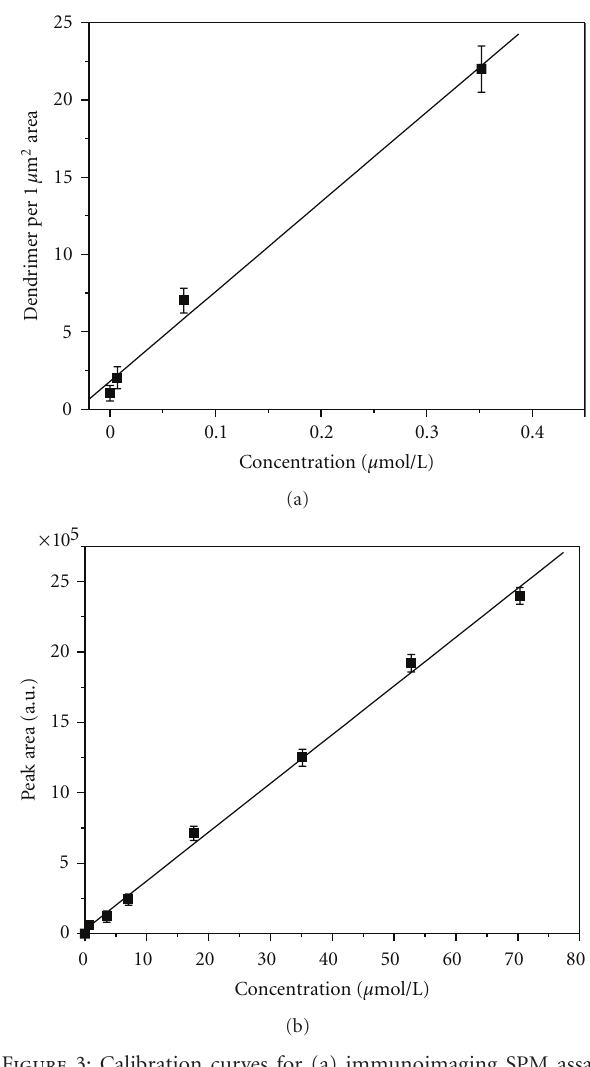
Figure 3: Calibration curves for (a) immunoimaging SPM assay and (b) HPLC analysis of G4 biotinylated PAMAM dendrimers. The SPM analysis represents the average number of dendrimers bound within a 1 × 1 μ m area for di ff erent concentrations of dendrimers. Data acquired from 10 capture substrates, with 10 images per sample ( y = 58 . 1 x + 1 . 76, n = 20, r 2 = 0 . 9964). The HPLC analysis represents an average of 10 samples for each concentration evaluated ( y = 34620 . 85 x + 28845 . 984, n = 10, r 2 = 0 . 9986).